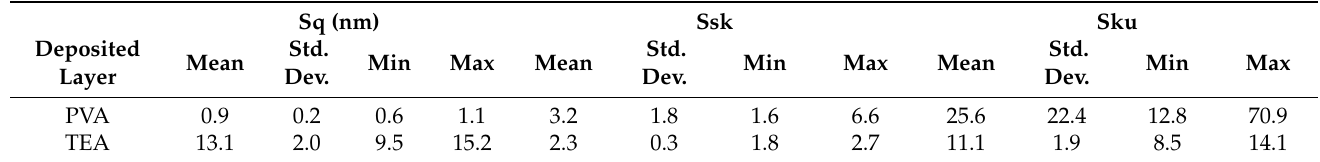
Table 3. Statistical Summary for the roughness parameters of PVA and TEA deposited by MAPLE on polished Si.